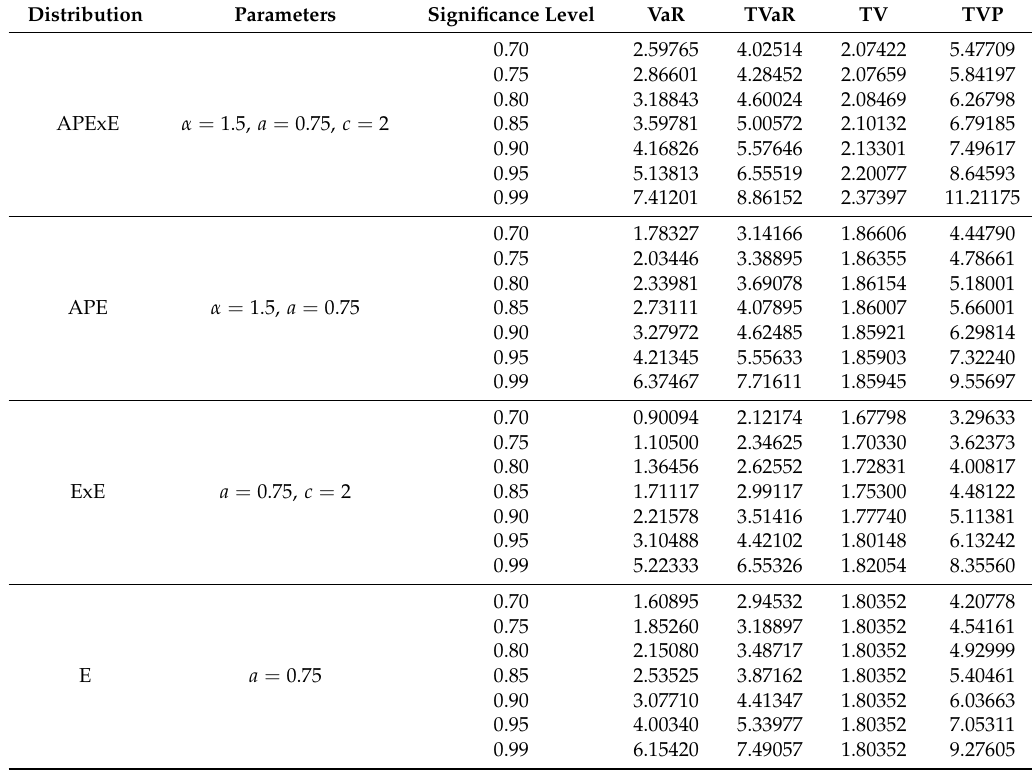
Table 2. Simulation results for the VaR, TVaR, TV, and TVP of the APExE, APE, ExE, and E distributions.